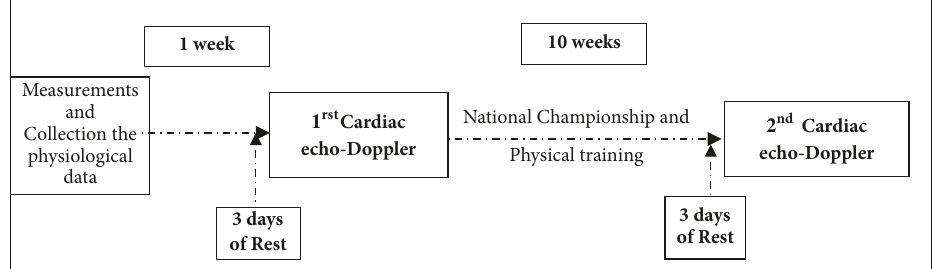
Figure 1: Study design and diagram of data acquisition among soccer referees of national and international level in Republic of Benin.